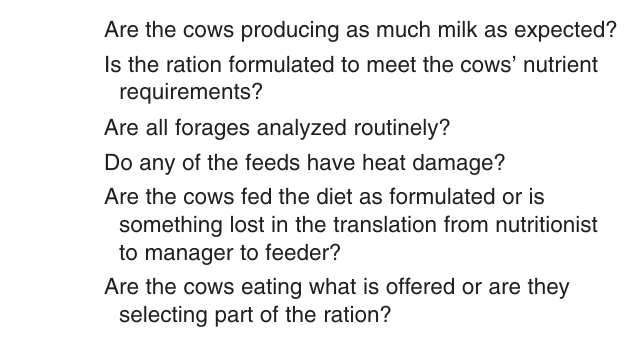
Check List to Identify Causes of High or Low MUN